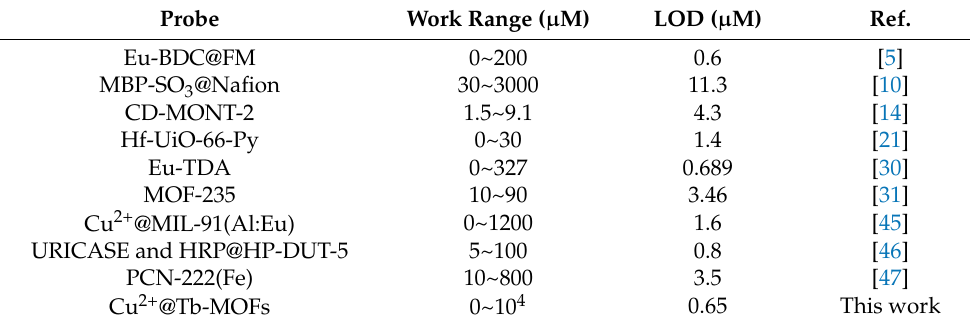
Table 1. The performance of different probes to detect